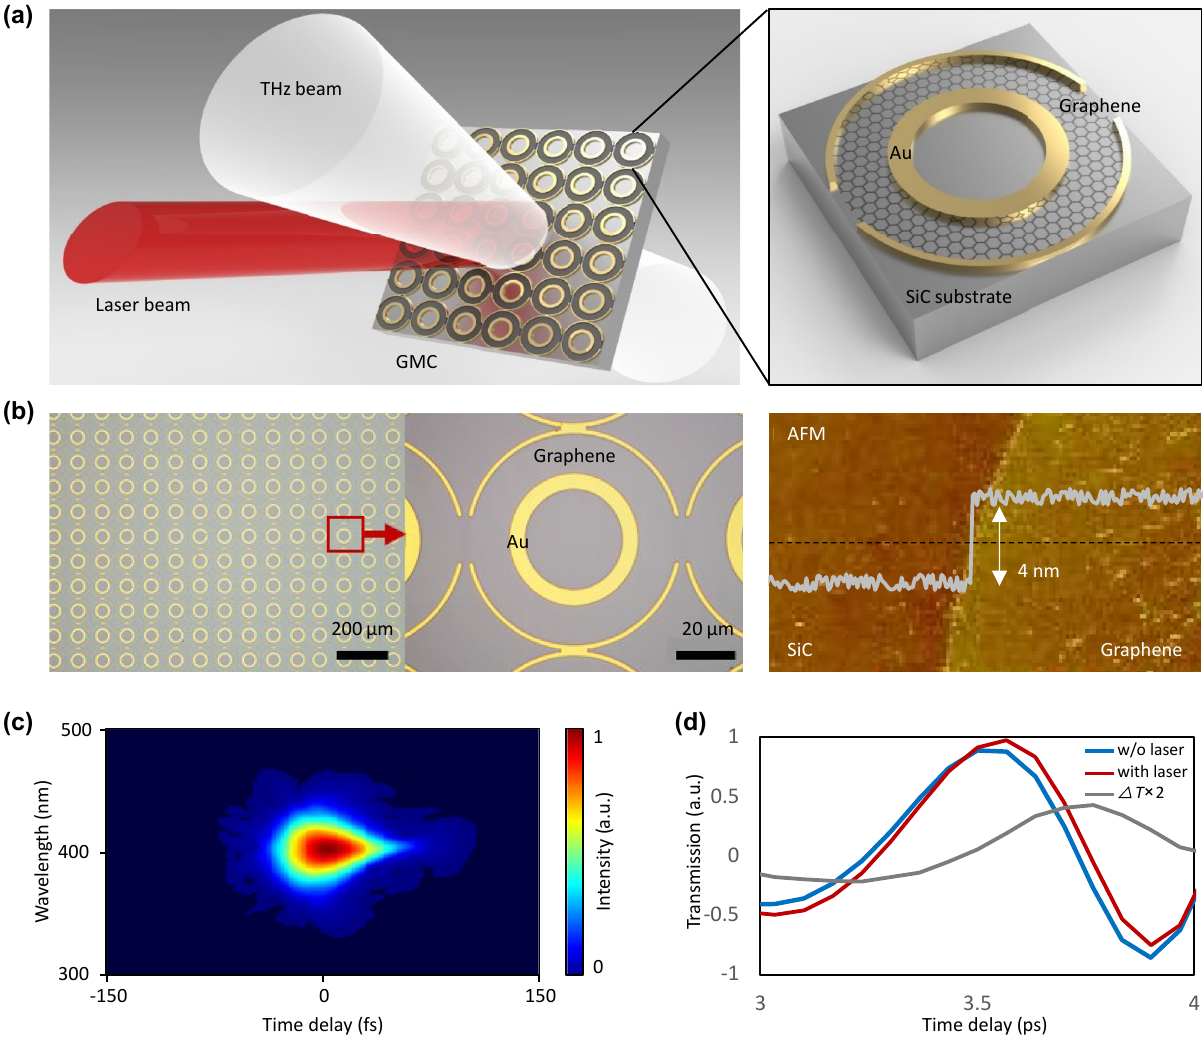
Figure 1: Conceptual design and implementation of the optically controllable terahertz waves. (a) Schematic of the graphene metasurface cavities (GMCs). Circular gold-graphene structures are deposited on a silicon carbide substrate, forming super-interference device for terahertz transmission. (b) Top-view of the GMCs, diameter of gold outer/inner ring is 80/40 μ m. The AFM map illustrates the graphene layer number is 7. (c) Measured FROG of the 800 nm titanium-gem mode-locked laser, the pulse width is 35 fs, suggesting peak power up to 10 GW/cm 2 on a sample. (d) Measured temporal traces of the terahertz transmission through the GMCs on silicon carbide, before (blue) and after laser irradiation (red).